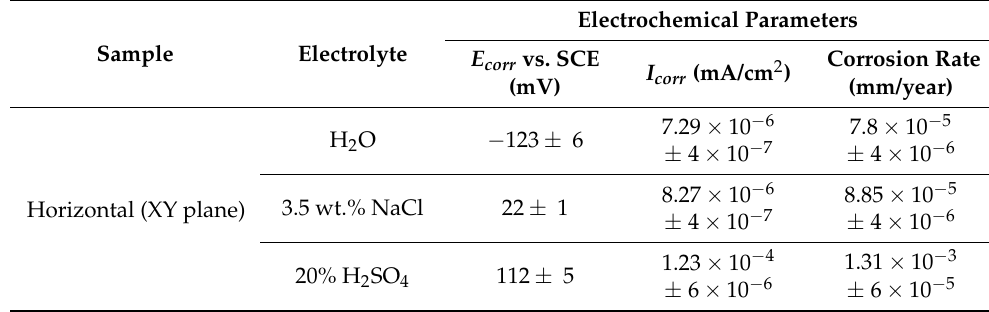
Table 3. Electrochemical parameters of the SLMed 316L SS tested in horizontal (XY